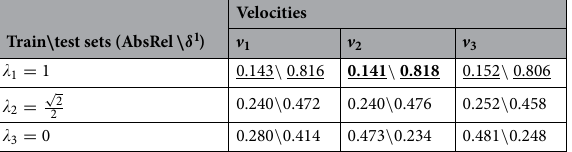
Train \ test sets (AbsRel \ δ 1 )